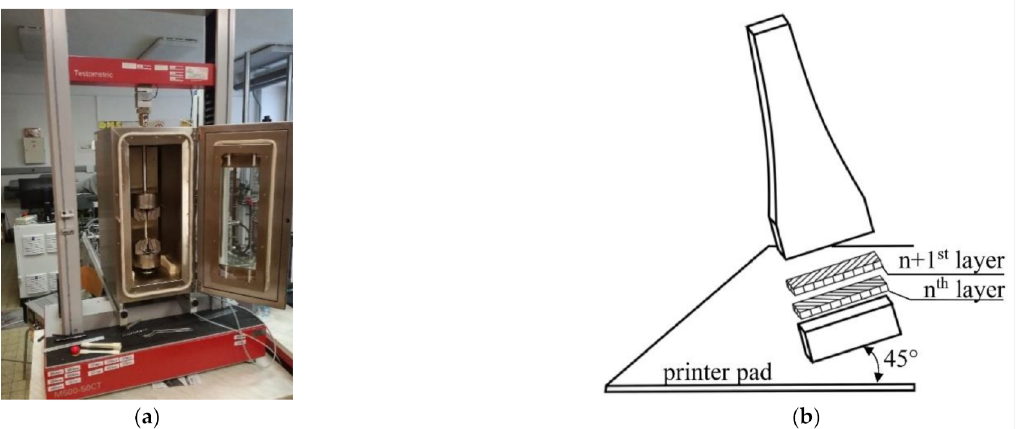
Figure 1. ( a ) The Testometric M500-50CT tensile testing machine equipped with a temperature chamber. ( b ) The position of specimens during 3D printing and the method used to layer the material.